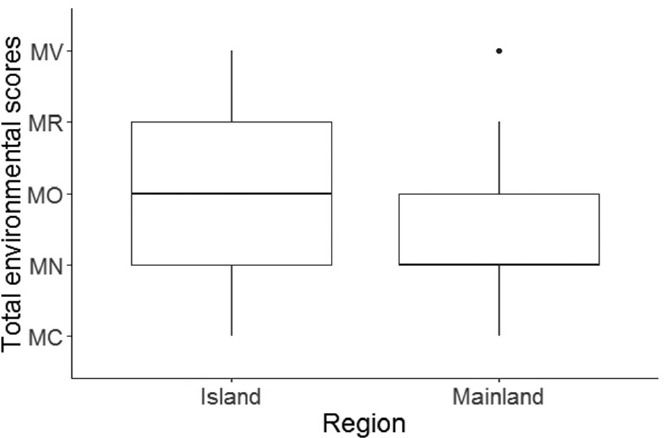
Figure 3. EICAT scores recorded on islands (n= 235) vs. mainlands (n= 167); p < 0.001. Each study containing an impact record was used separately for this analysis, with n indicating the number of studies found per region over all